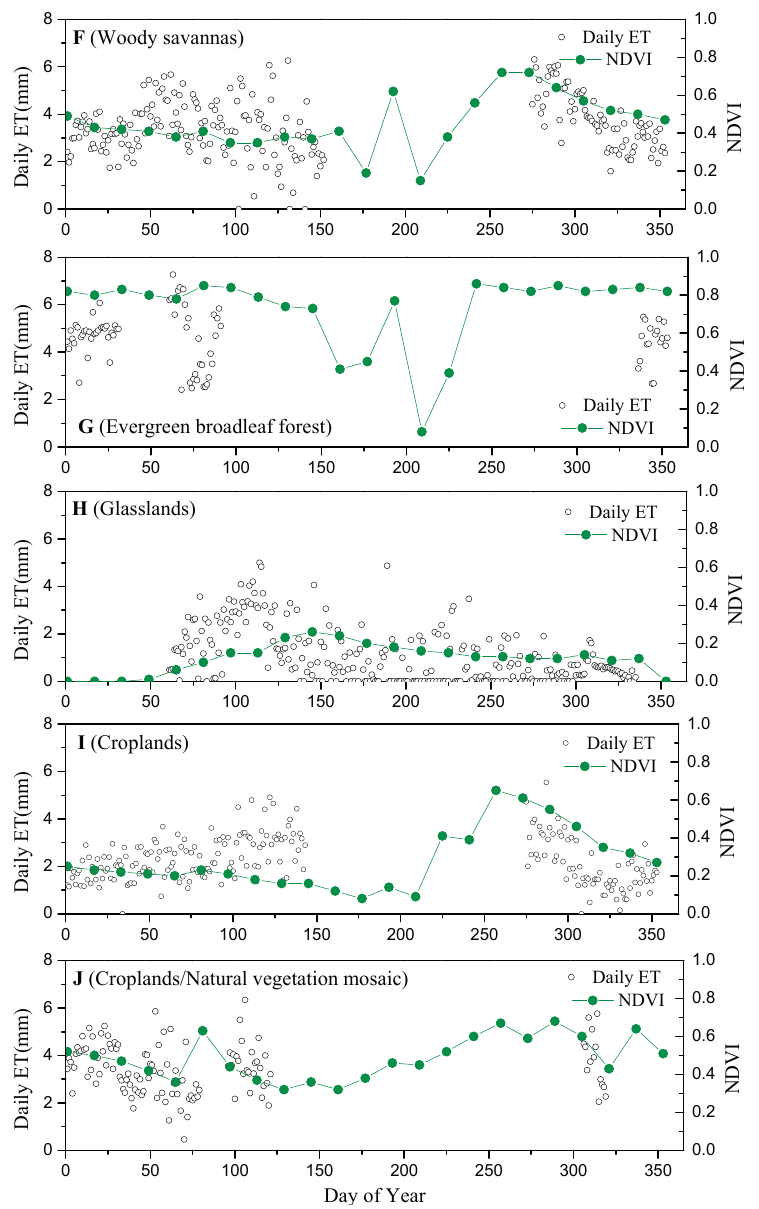
Figure 9. Temporal variation of daily ET ( cycle ) and NDVI ( green symbol line ) of the sampling sites A-J with different land cover types listed in Table